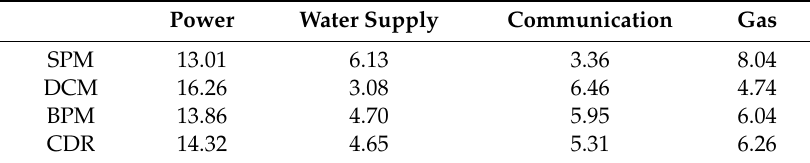
Table 3. Cost-sharing of pipeline companies (Unit: 10 4 CNY).